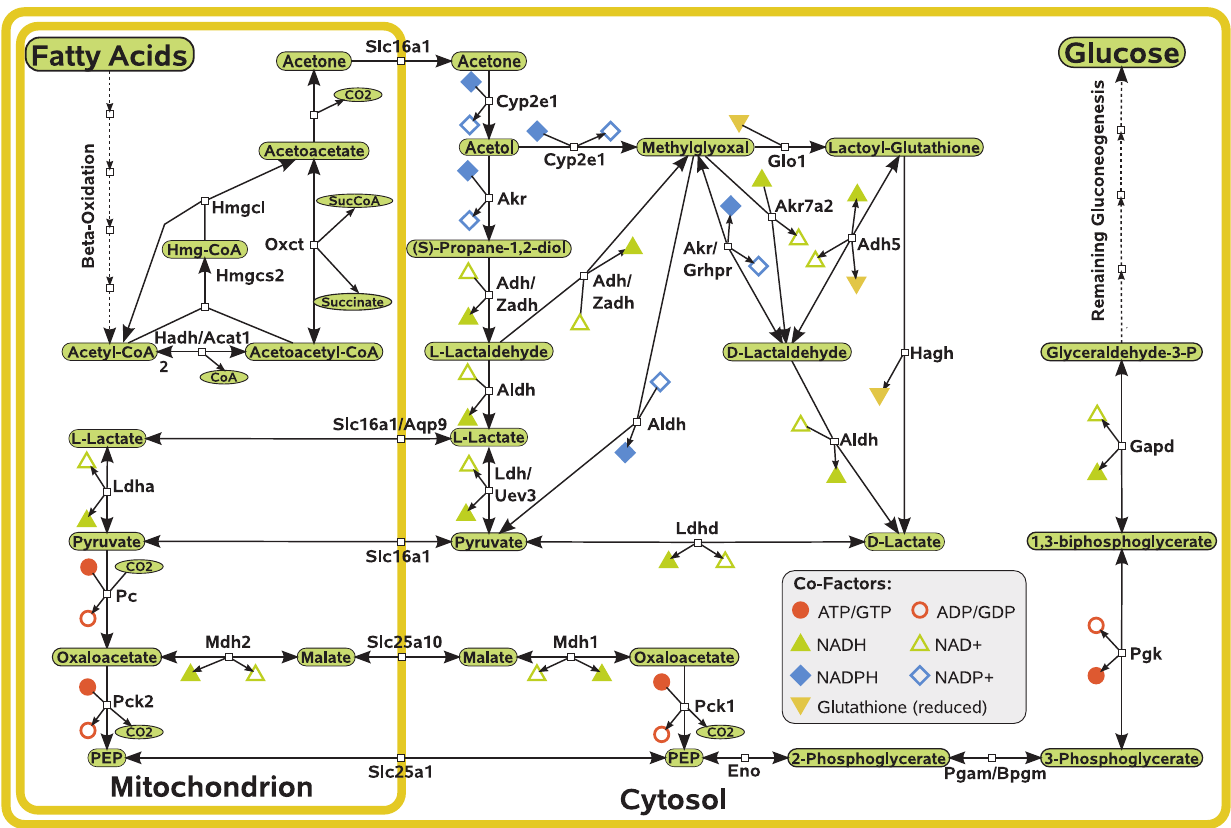
Figure 4. Gluconeogenic pathways from fatty acids. Only mitochondrial pathways for ketogenesis are shown since they represent the most important routes. Aqp9, Akr and one form of Acat2 are noted as irreversible in the model, but are lumped together with reversible reactions in the figure. A list of abbreviations can be found in Table S1. A complete list of pathways in ketogenesis and acetone metabolism is given in Text S1.